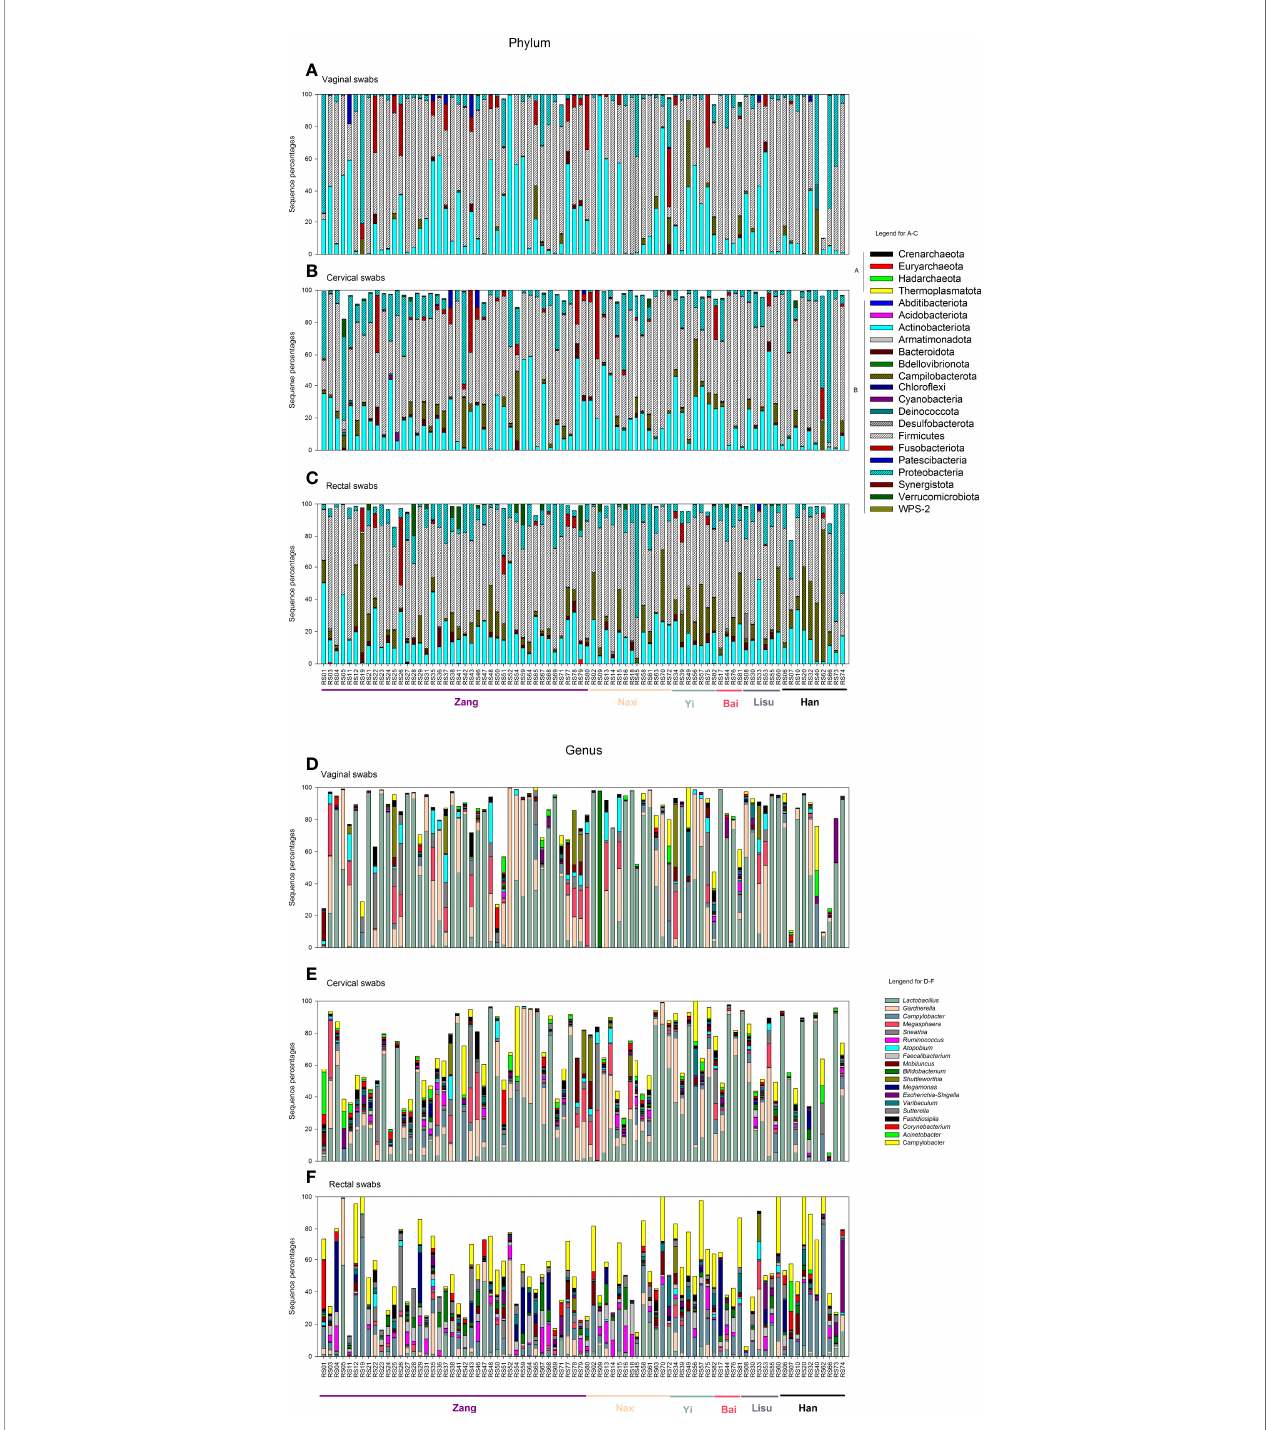
FIGURE 2 | Vaginal, cervical, and rectal microbiota distribution. (A – C) Vaginal, cervical, and rectal microbiota distribution at the phylum level. (D – F) Vaginal, cervical, and rectal microbiota distribution at the genus level. (A, B) in panels (A – C) indicate the phyla belonging to Archaea and Bacteria. Different ethnic groups are marked in the bottom of the columns with different colors (Zang: purple; Naxi: skin; Yi: mint green; Bai: rose red; Lisu: dark gray; Han: